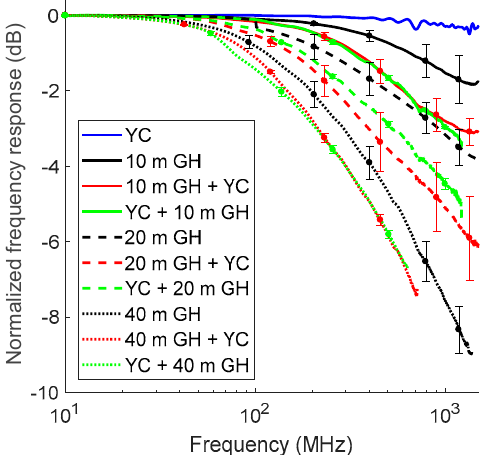
Figure 8. Normalized frequency responses for the Y-coupler (blue), GH-fiber segments of different lengths (black) and several link configurations (i.e., the coupler at the receiver end (red), and the coupler at the emitter end (green)).